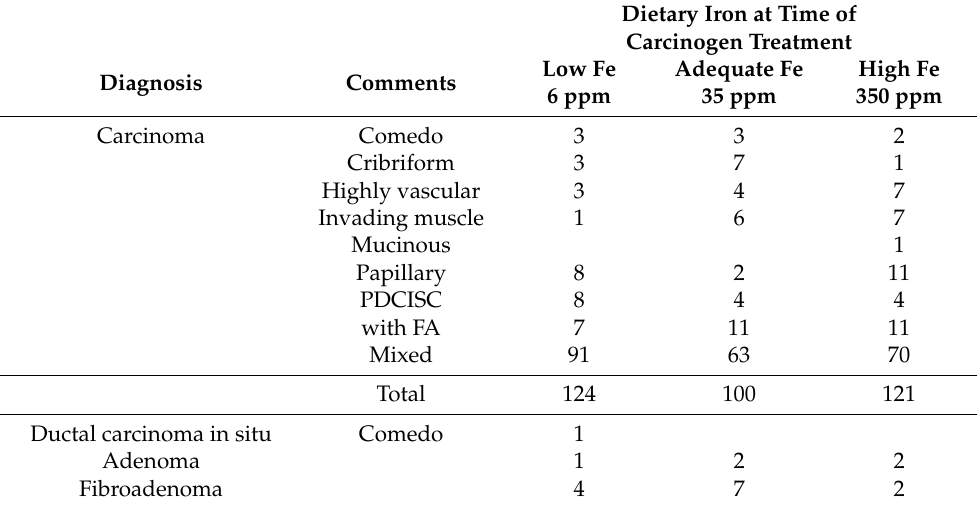
Dietary Iron at Time